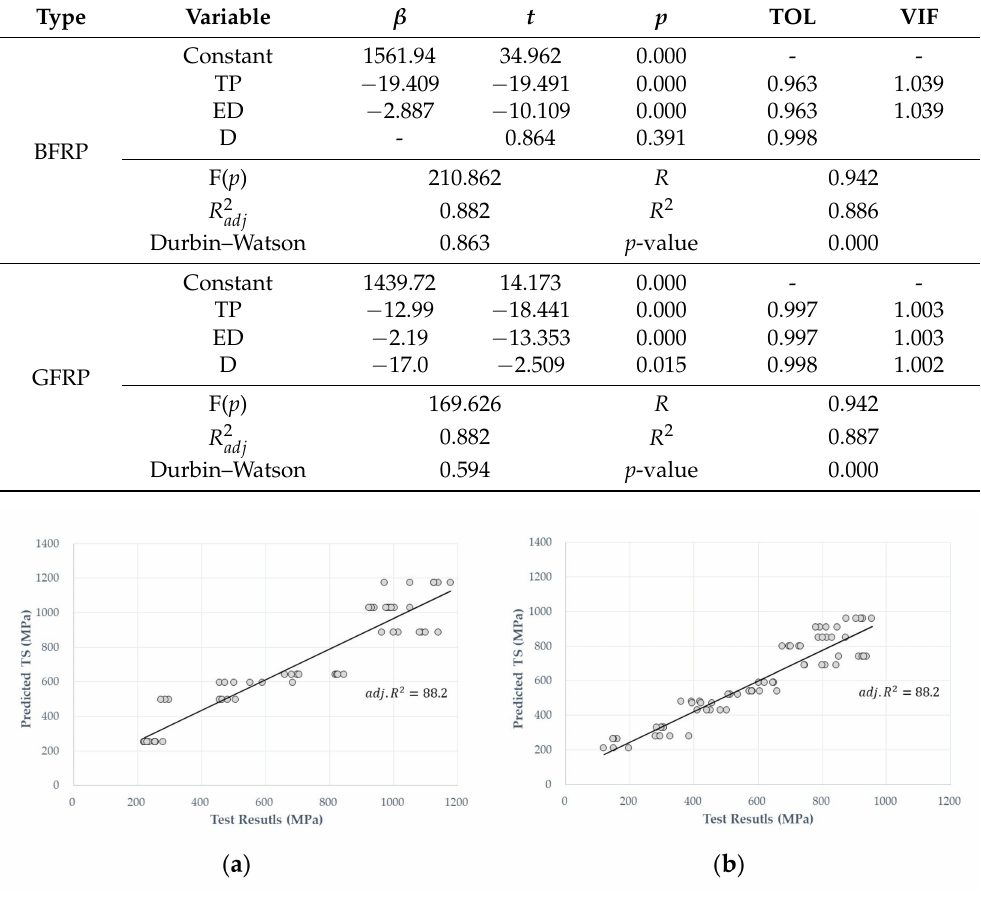
Table 3. MRA results of BFRP and GFRP.